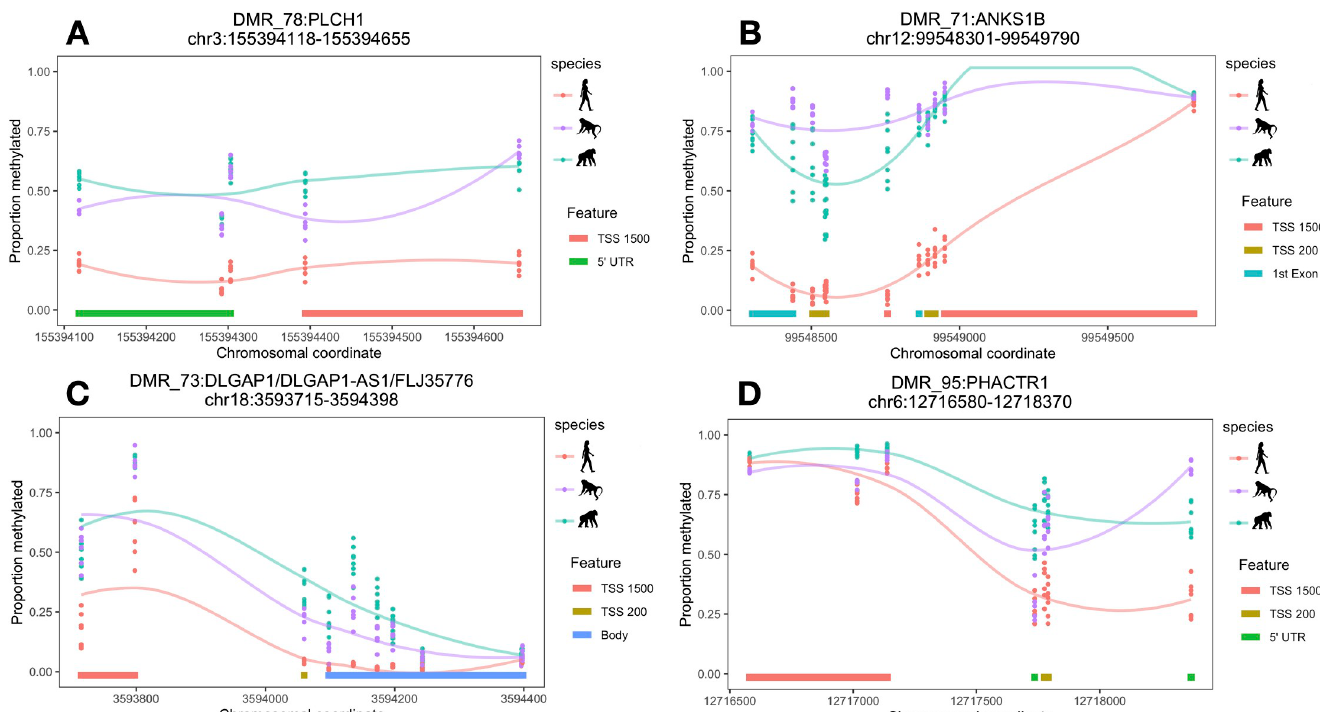
Fig 3. Cerebellum-specific human regDMRs associated with PLCH1 , ANKS1B , DLGAP1 , and PHACTR1 . A = PLCH1 , B = ANKS1B , C = DLGAP1 , D = PHACTR1 . Lines are loess smoothed methylation values for each species across the DMR and each point represents raw methylation values for each individual at each CpG site within the DMR ranges. TSS200 = within 200 bp of a transcription start site and TSS1500 within 1500 bp of a transcription start site. Chromosomal coordinates are in base pairs and refer to human genome build